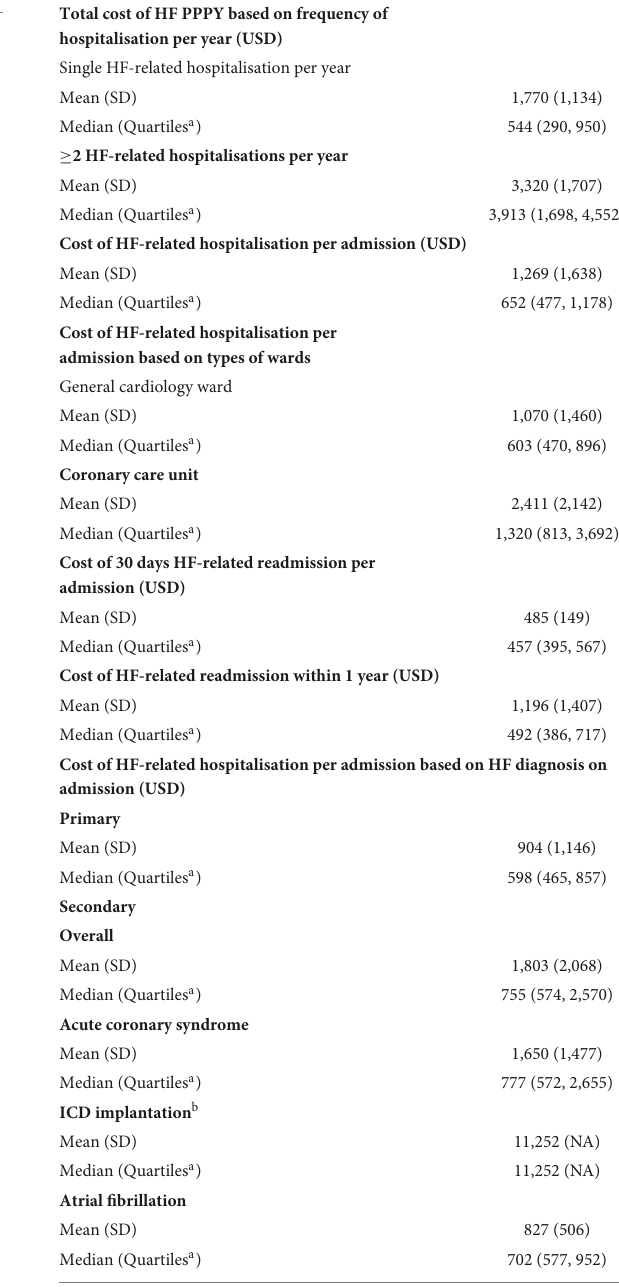
TABLE 5 Sub-analysis in patients who had heart failure hospitalisation. Patient